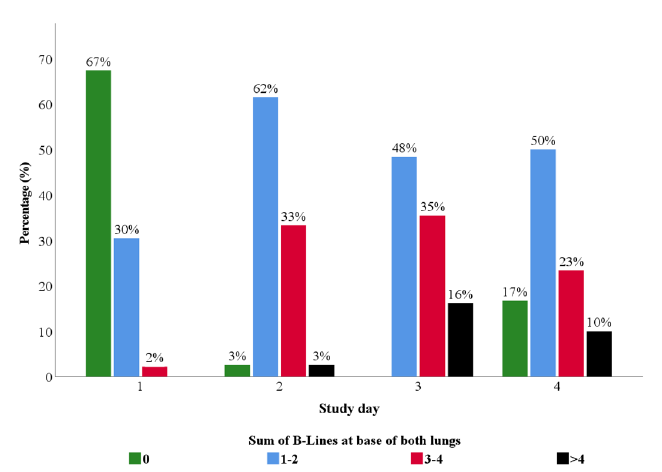
Figure 1. Distribution of the sum of B-lines at the base of both lungs over four days at altitude.